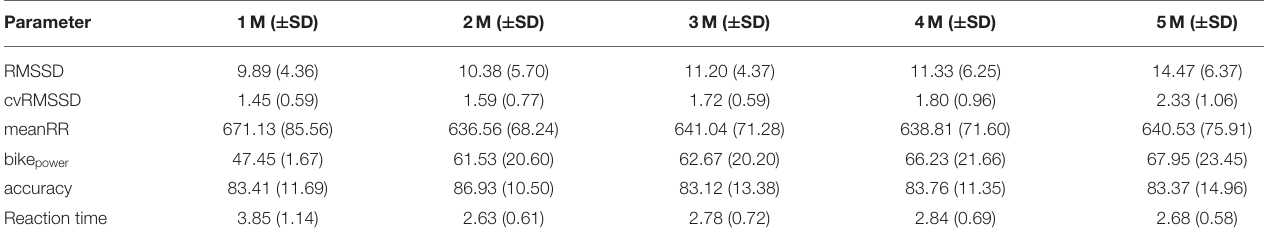
TABLE 2 | Descriptive statistics of the primary and secondary outcomes.